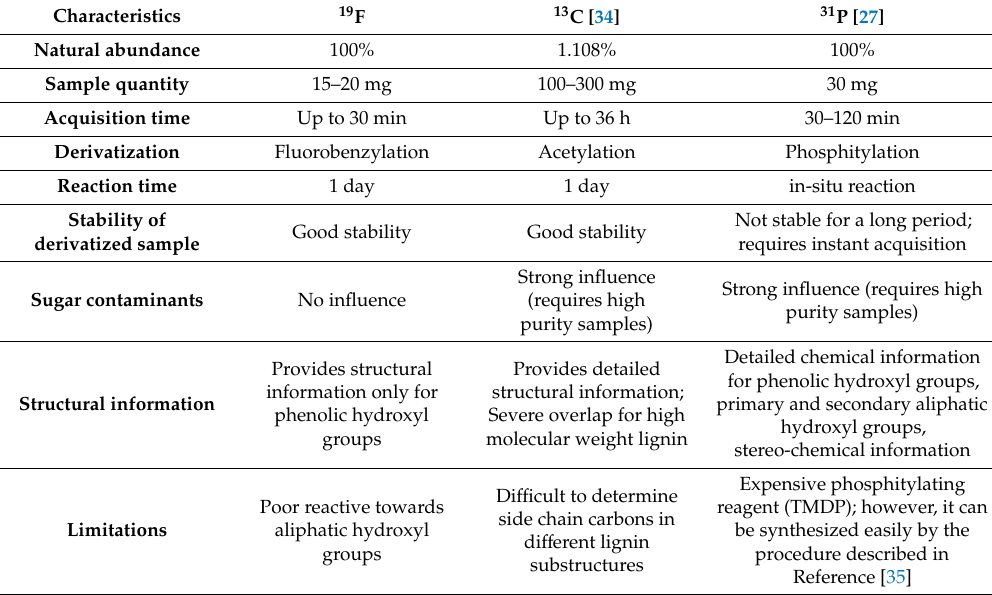
Table 7. Summary of distinctive characteristics of 19 F, 13 C and 31